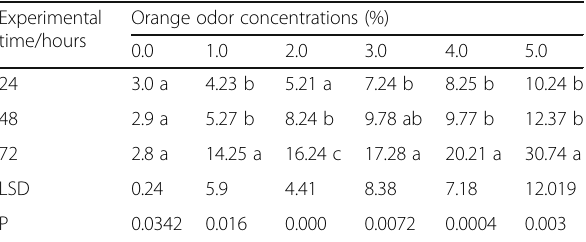
Table 2 Percentages of unhatched Spodoptera littoralis eggs in three exposure periods to different concentrations of orange odor Experimental time/hours